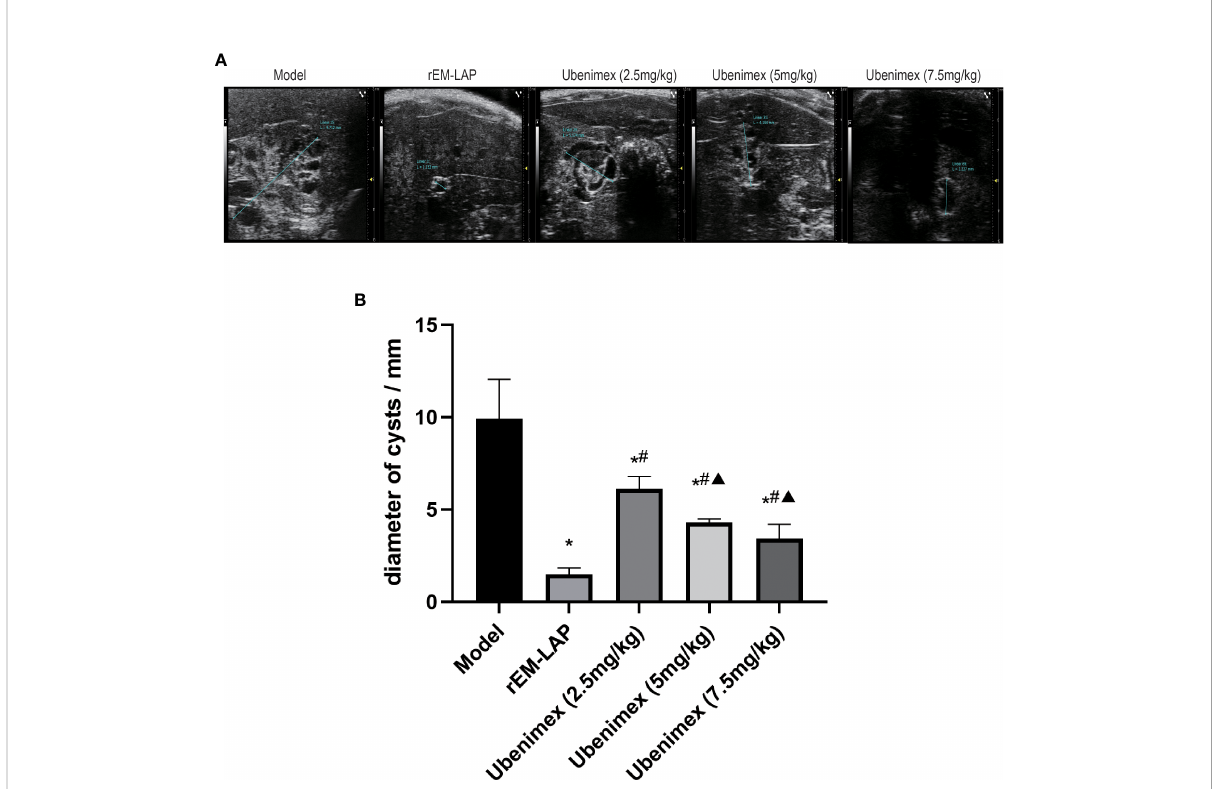
FIGURE 1 Ultrasonography. (A) Cysts in different mouse models by Ultrasonography. (B) The maximum diameter was measured by Ultrasonography. (*- p<0.05 v.s. Model group; # - p<0.05 v.s. rEM-LAP group; ▲ : p<0.05 v.s. 2.5 mg/kg Ubenimex group. n=6, a